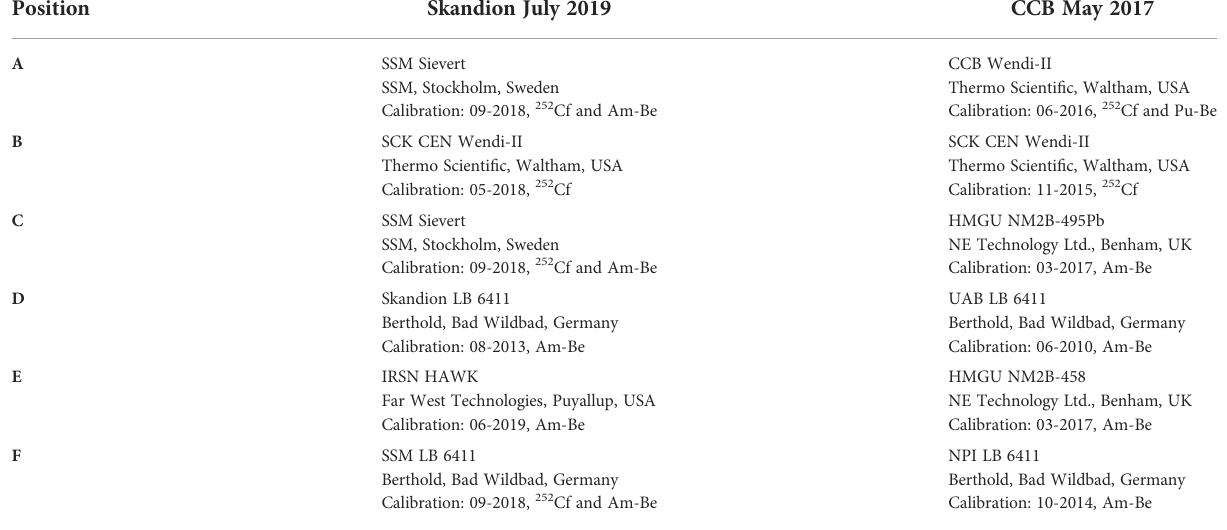
TABLE 2 Ambient neutron monitors used at the different positions at Skandion and CCB.